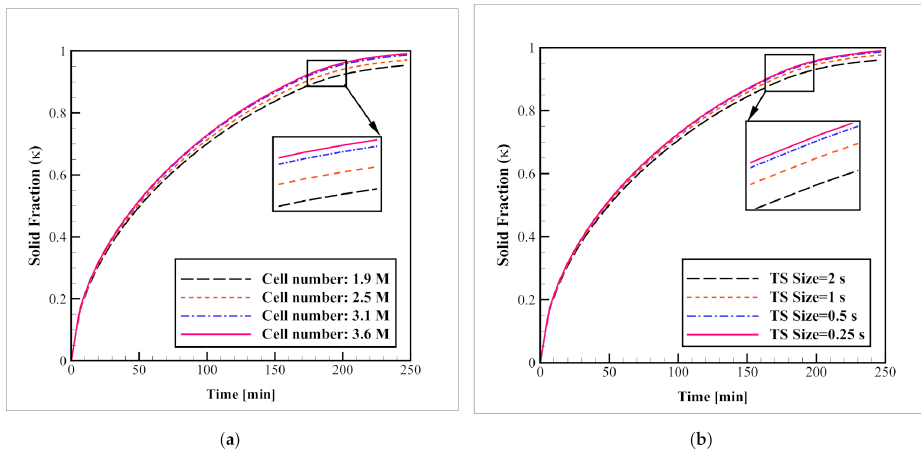
Figure 4. The ( a ) mesh size independence, and ( b ) time-step size tests.